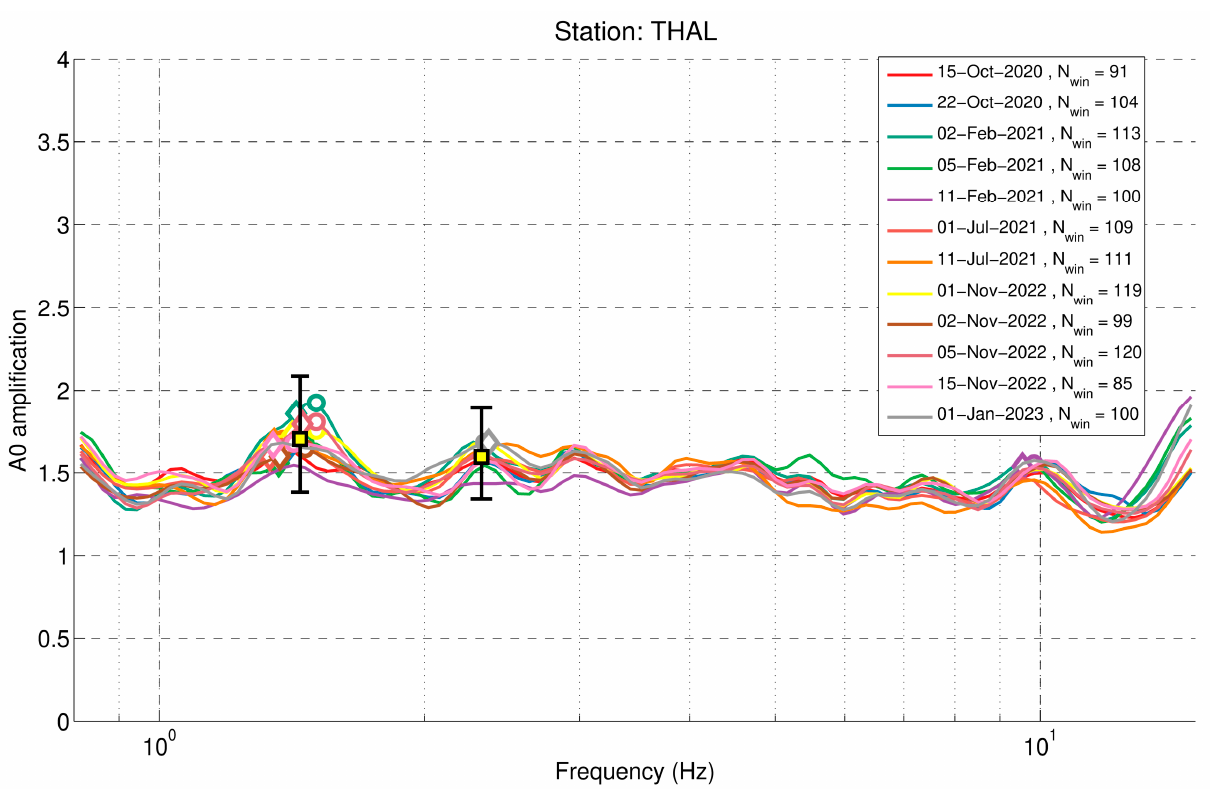
Figure 12. Location of the seismological station THAL and the geophysical measurements along with the geology of the area.